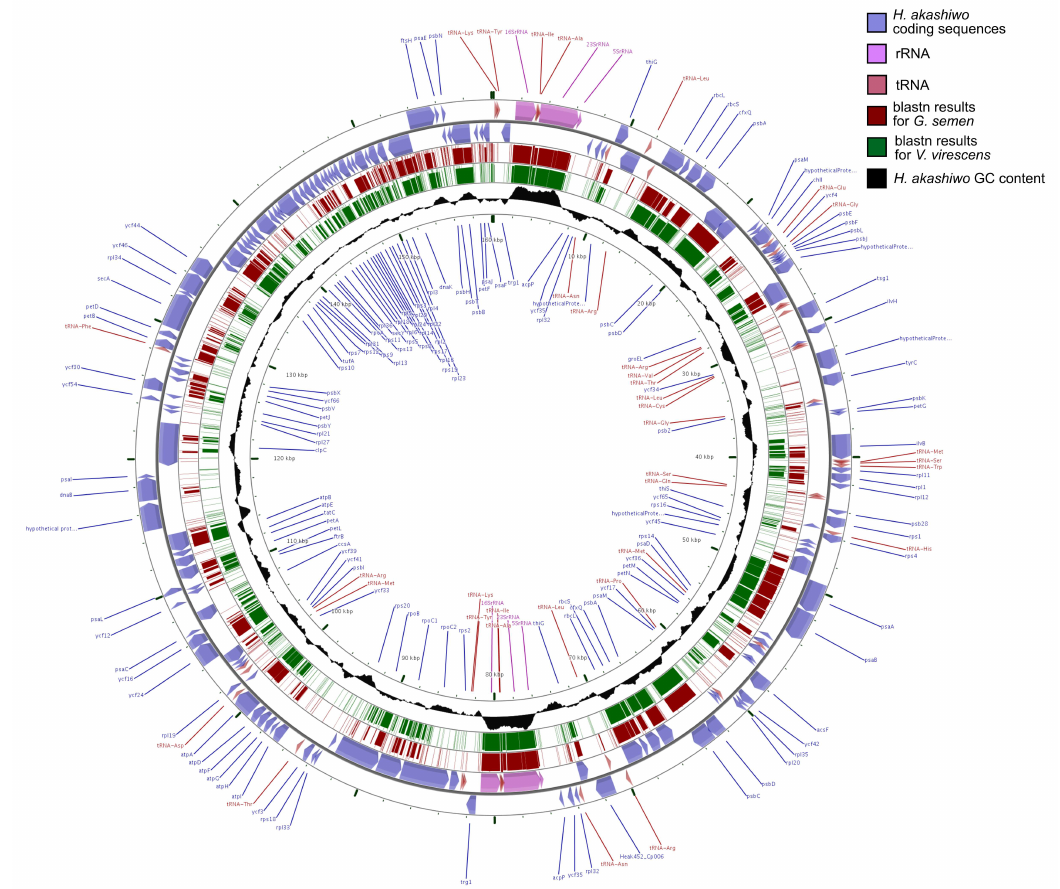
Figure 1. Sequence similarities based on blastn between to the circular chloroplast genome of H. akashiwo (~160 kbp) and chloroplast contigs of G. semen and V. virescens visualized with CGView. Coloured regions on the G. semen and V. virescens rings correspond to fragments matching the reference genome. The GC content of the H. akashiwo chloroplast genome averages at